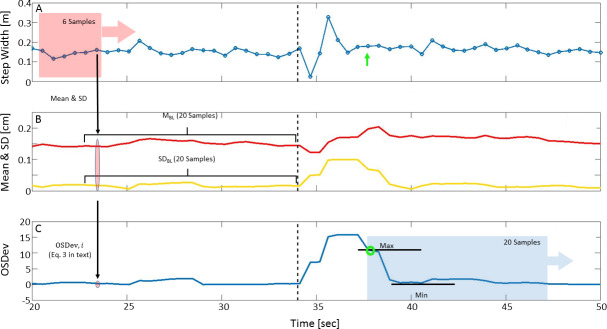
Algorithm performance steps.(A) Graph of step width values (blue circles; connected to graphically enhance perturbation effect). (B) Implied graphs for means (M; red) and standard deviations (SD; yellow), calculated using a moving window of six samples. Each point in the graphs represents data from six preceding original data points (depicted by the black vertical arrow between panel A and B). For each implied graph, 20 samples prior to perturbation onset were taken as baseline (MBL and SDBL, denoted by horizontal black brackets). (C) MBL and SDBL were used to standardize the implied graphs, to create the overall sum of deviations (OSDev–blue line, calculated using Eq 3). To determine the recovery point, the algorithm scanned the OSDev graph from left to right, using a moving window of 20 values starting at perturbation onset. The recovery point is then defined using a mathematical criterion (see S1 Appendix) that assesses minimal changes in signal amplitudes (green circle; corresponds to the original step value indicated by the green arrow in panel A).